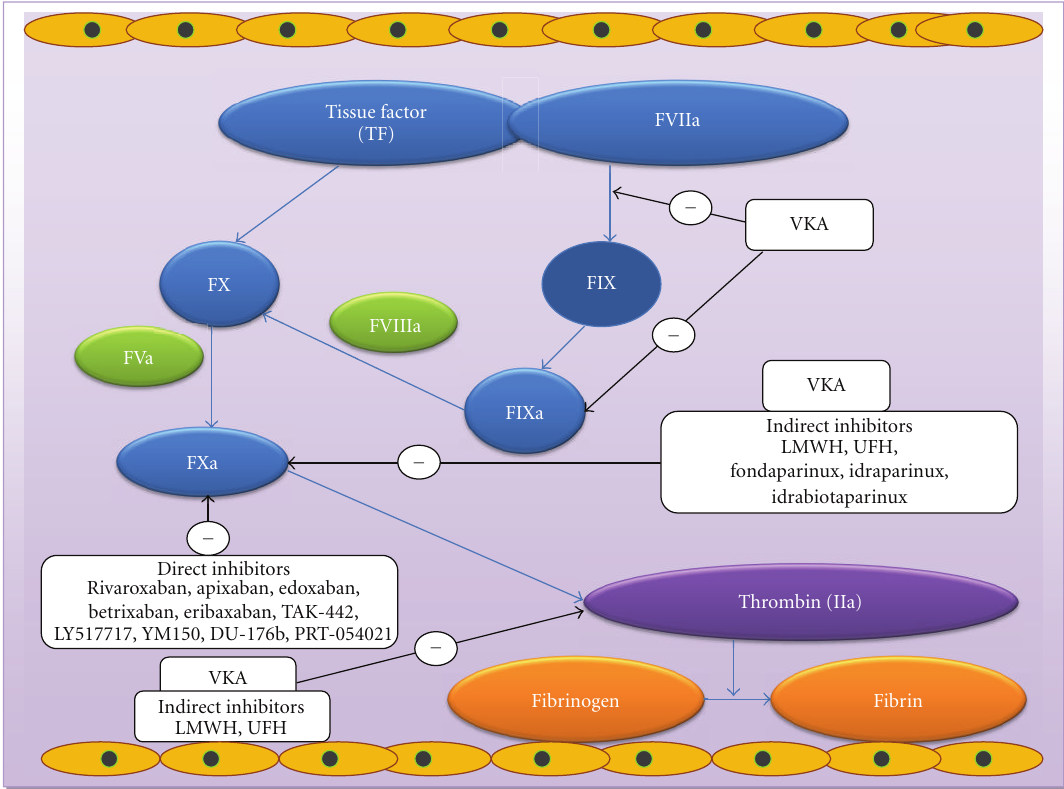
Figure 1: Mechanism of action of anticoagulants. Abbreviations: vitamin k antagonist (VKA); low-molecular-weight heparin (LMWH); unfractioned heparin